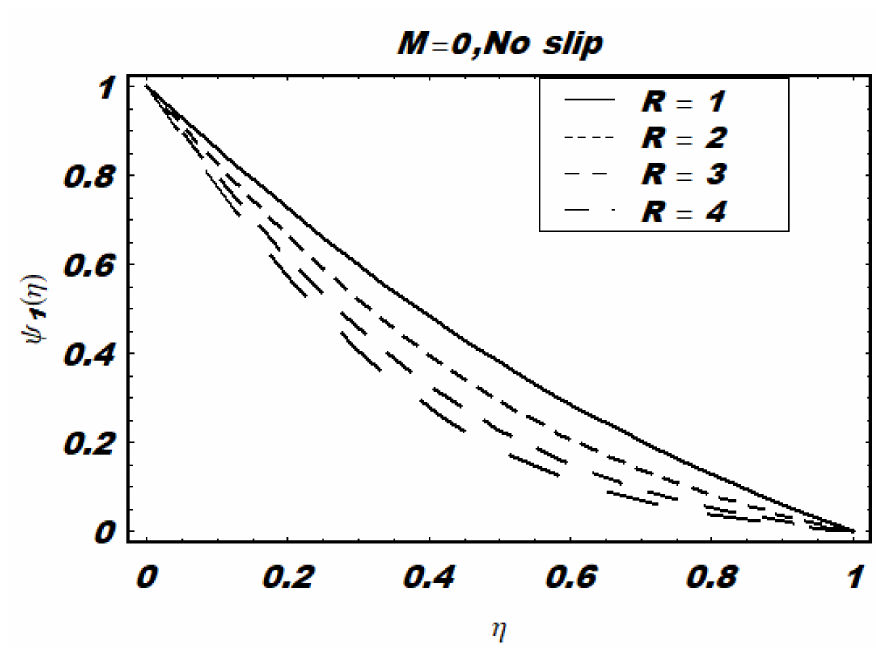
Figure 9. Similarity function ψ 1 for the long